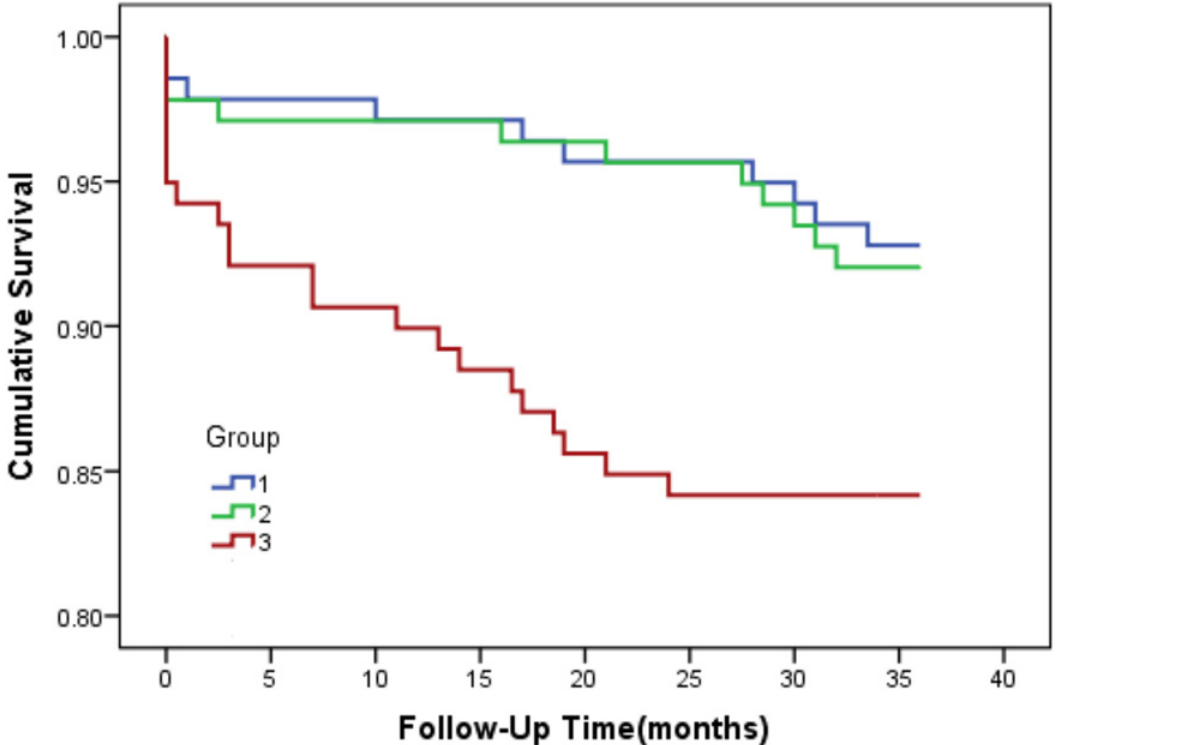
Fig 3. Kaplan-Meier curves depicting freedom from all-cause mortality according to the TG/HDL-C tertile.